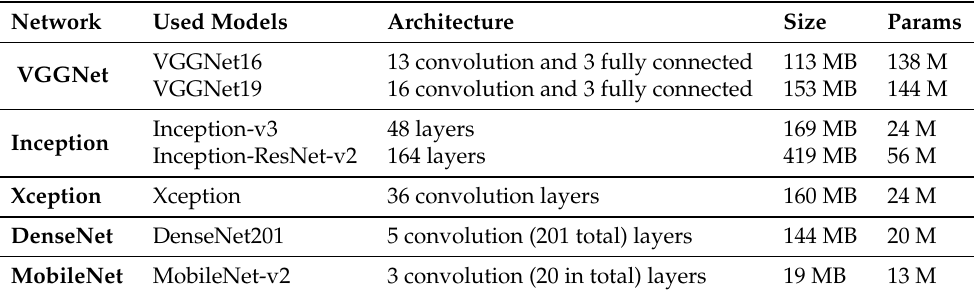
Table 2. Summary of networks used in our